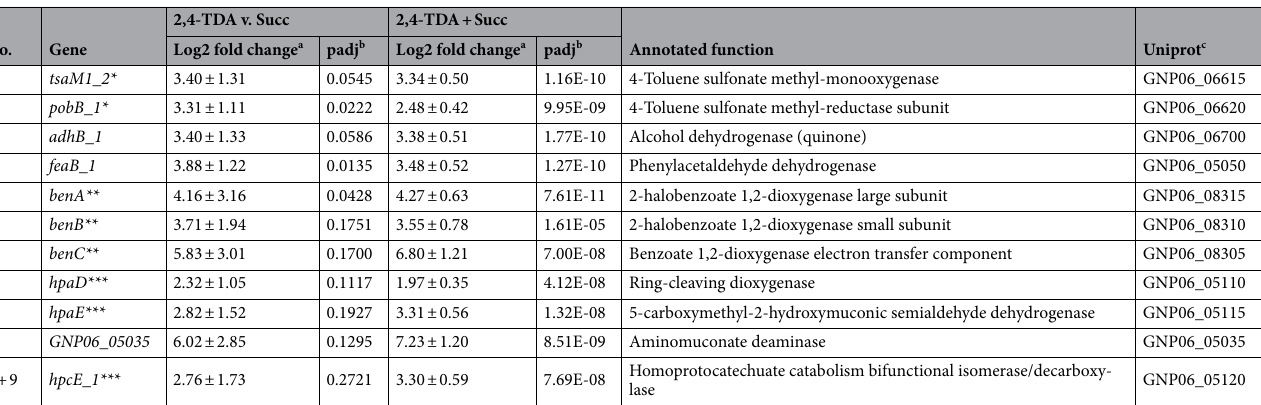
Table 1. List of gene candidates for the intracellular degradation pathway of 2,4-TDA in P. capeferrum TDA1 ( see Fig. 2). */**/***Adjacent genes (to each other). a log2 Fold Change ± standard error (LFC). b p-value adjusted (versus control, i.e., succinate). c Uniprot refers to the accession number of the TDA1 protein in this